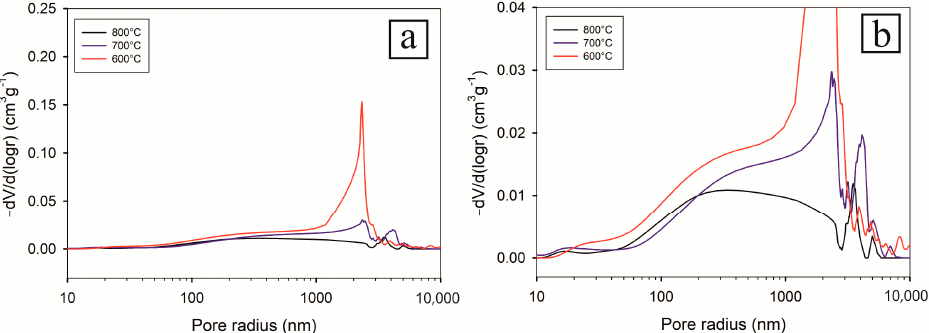
Figure 15. Pore size distribution of oxidized samples after thermocycling at 800 °C in argon: whole range ( a ), detail ( b ).